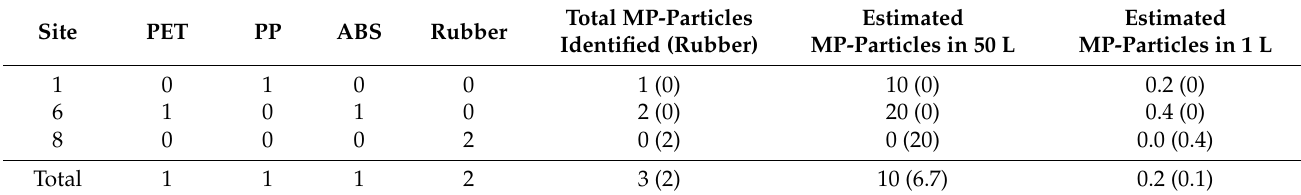
Table 1. Number and ID of MP-particles (>10 µ m) in tap water detected by Anodisc analysis. Anodisc analysis was performed on three randomly selected water samples from location 1, 8 and 6, respectively. The analysis was performed on 10% of the sample disc area from each of the water samples, corresponding to examination of 5 L of the sampled water volume. Number of rubber particles are shown in parenthesis. PET = polyethylene terephthalate, PP = polypropylene, PA = polyamide, ABS = acrylonitrile